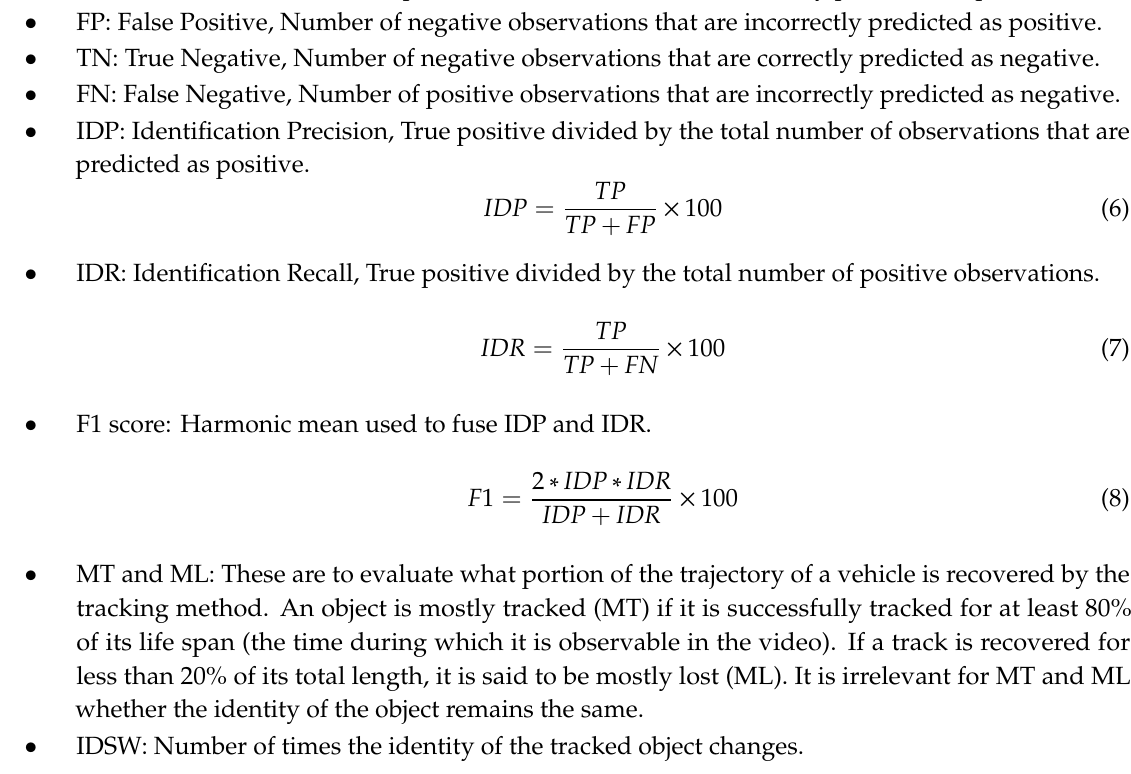
Figure 8. The red polygon denotes the region of interest for evaluating the tracking technique; it comprises the roundabouts and ramps, which are examples of complex road structures.